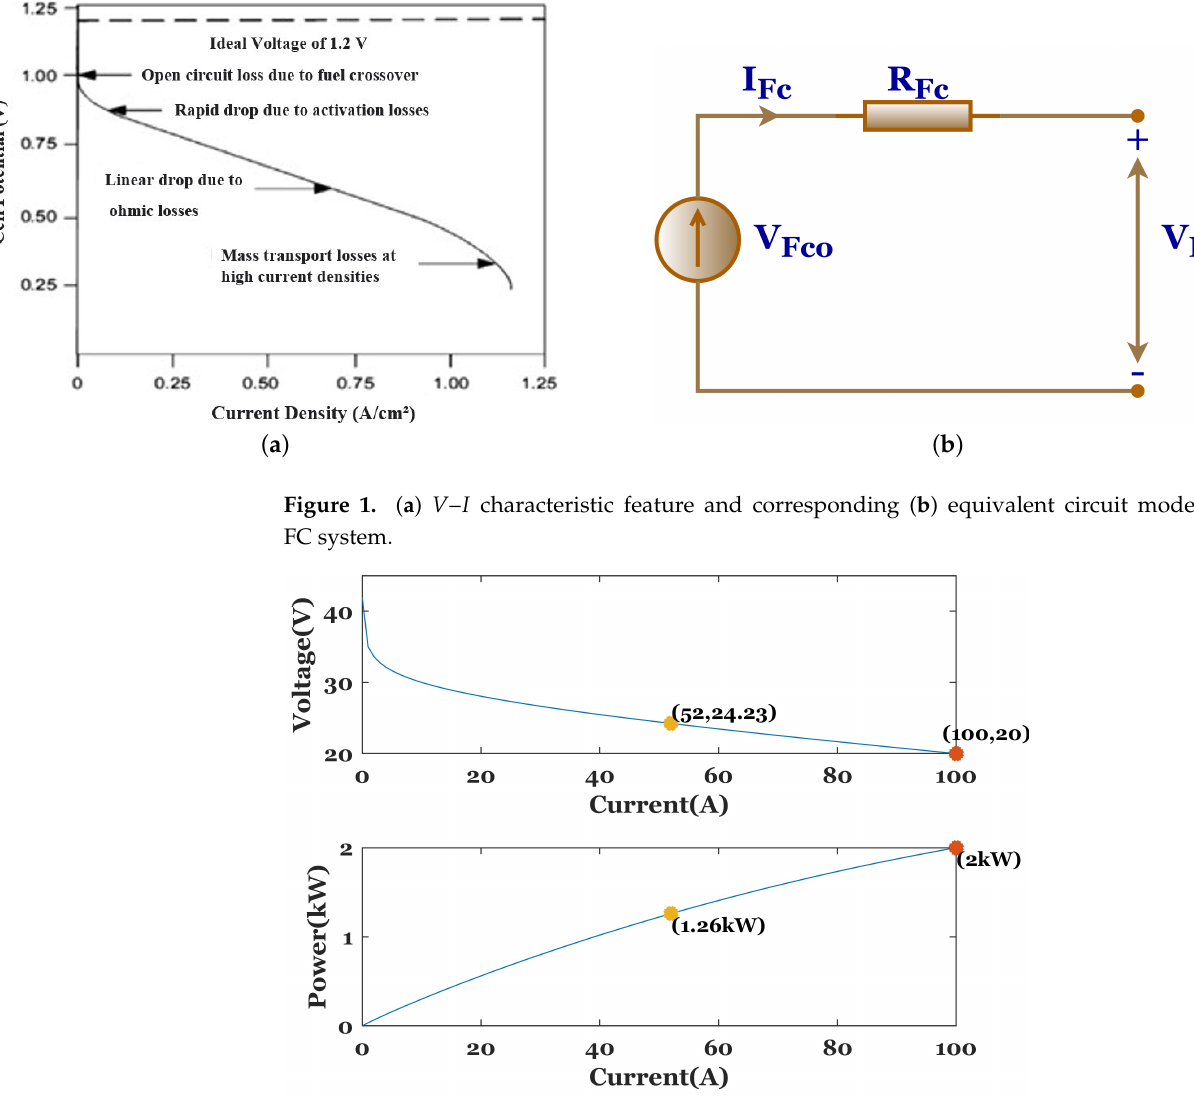
Figure 2. FC stack